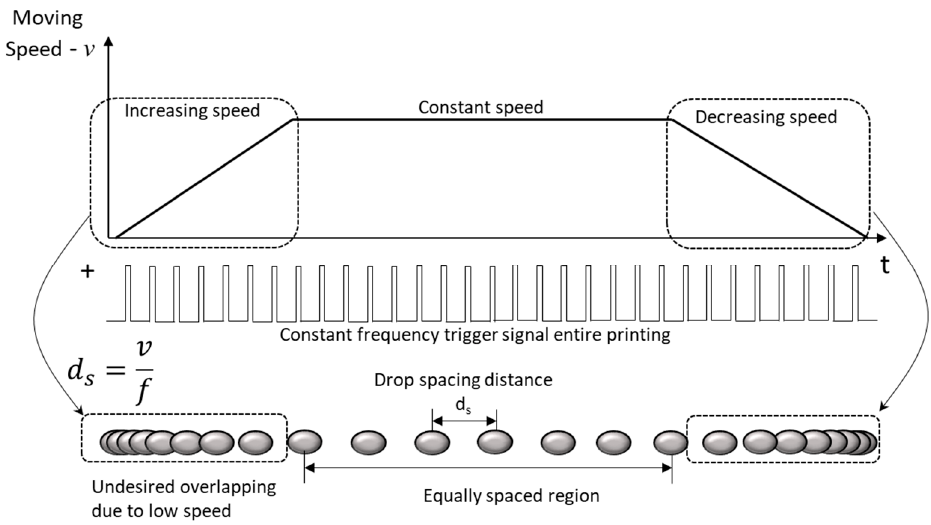
Figure 2. Non-uniform jetting due to printing speed variation.